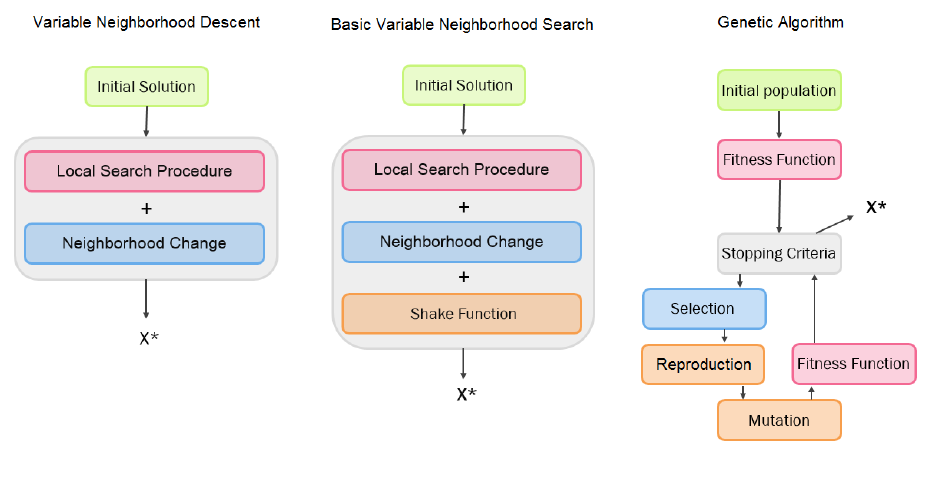
Figure 3. Schematic representation of the algorithms workflow. Variable Neighborhood Descent (VND) systematically changes the neighborhood in two phases: descent to find a local optimum and perturbation phase to get out of the corresponding valley. Basic Variable Neighborhood Search (BVNS) is a version of VND adjusted with the shake function. Genetic algorithm relies on biologically inspired operators such as mutation, crossover and selection. X* defines resulting